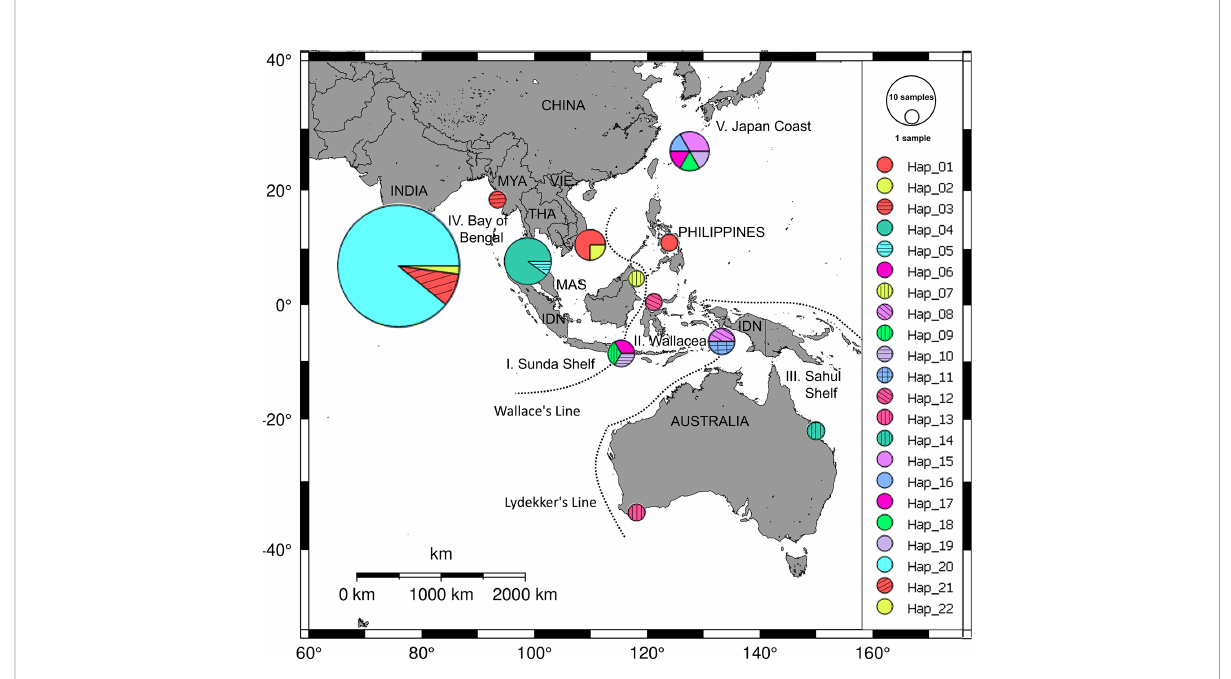
FIGURE 5 Distribution of haplotype frequency of Halophila major . Twenty-two haplotypes were found from dataset of 69 ITS sequences of H. major collected in fi ve geographic regions: Sunda Shelf (I), Wallacea (II), Sahul Shelf (III), Bay of Bengal (IV), and coast of Japan (V). Source: Nguyen et al.